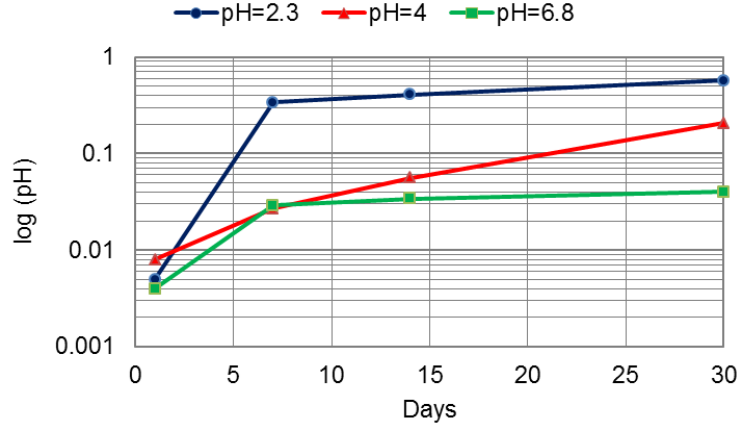
Figure 6. The difference between the release of Cr from the CM and DMLS alloys